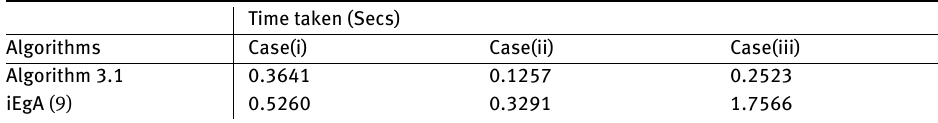
Table 2: Comparison between Algorithm 3.1 and iEgA (9) for Example